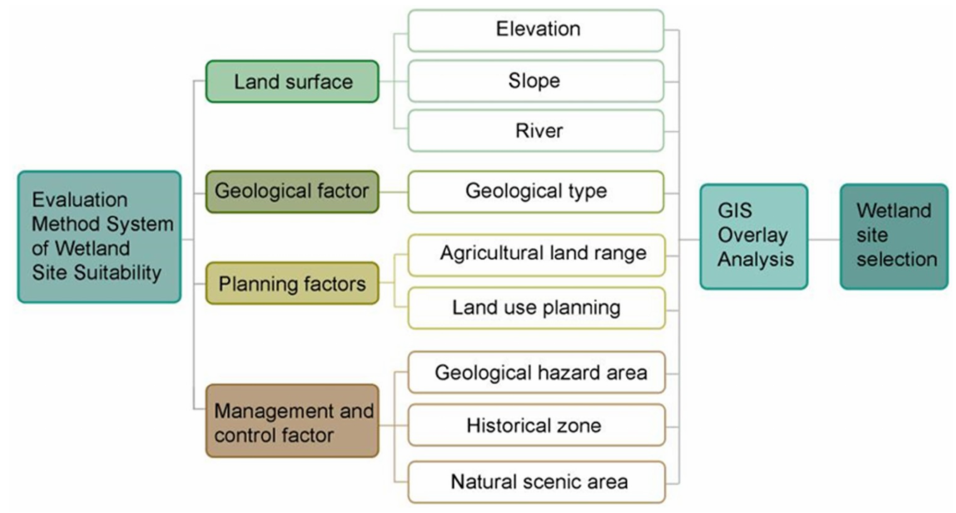
Figure 2. Technical route of constructed wetland site selection using Geographical Information System